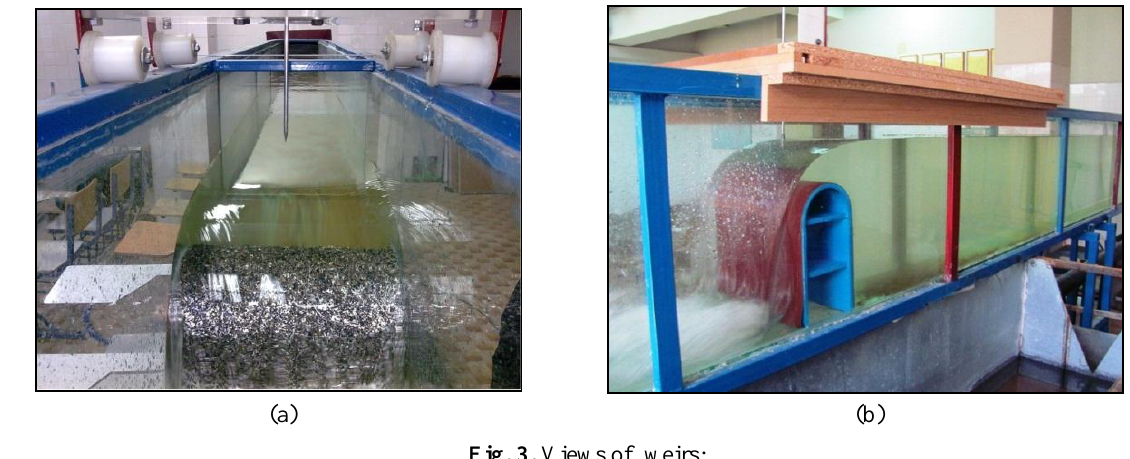
Fig. 3. Views of weirs: